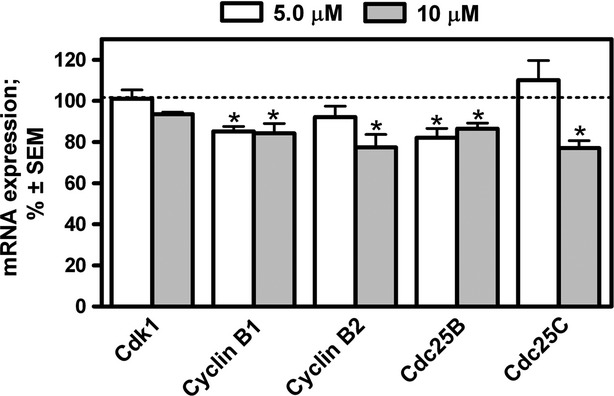
Effects of 5.0 μM (open bars) and 10 μM (grey bars) d-homoestrone on the mRNA expression of regulating factors participating in the G2/M transition in HeLa cells after incubation for 48 hrs, determined by reverse-transcription PCR. Results are mean values ± SEM of the data from two separate measurements, n = 6. * indicates P < 0.05 as compared with the untreated control samples (dashed line at 100%). Non-significant changes are not indicated. Cdk1 denotes cyclin-dependent kinase 1.